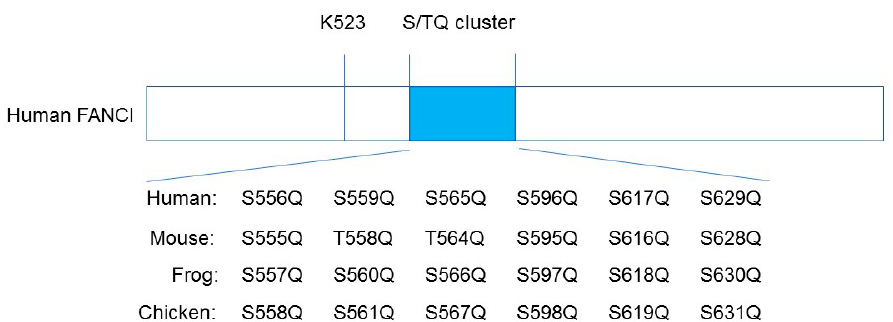
Figure 2. Schematic diagram of human FANCI, indicating the six putative phosphorylation sites within the S/TQ cluster domain. K523 is the monoubiquitination site of the human FANCI.